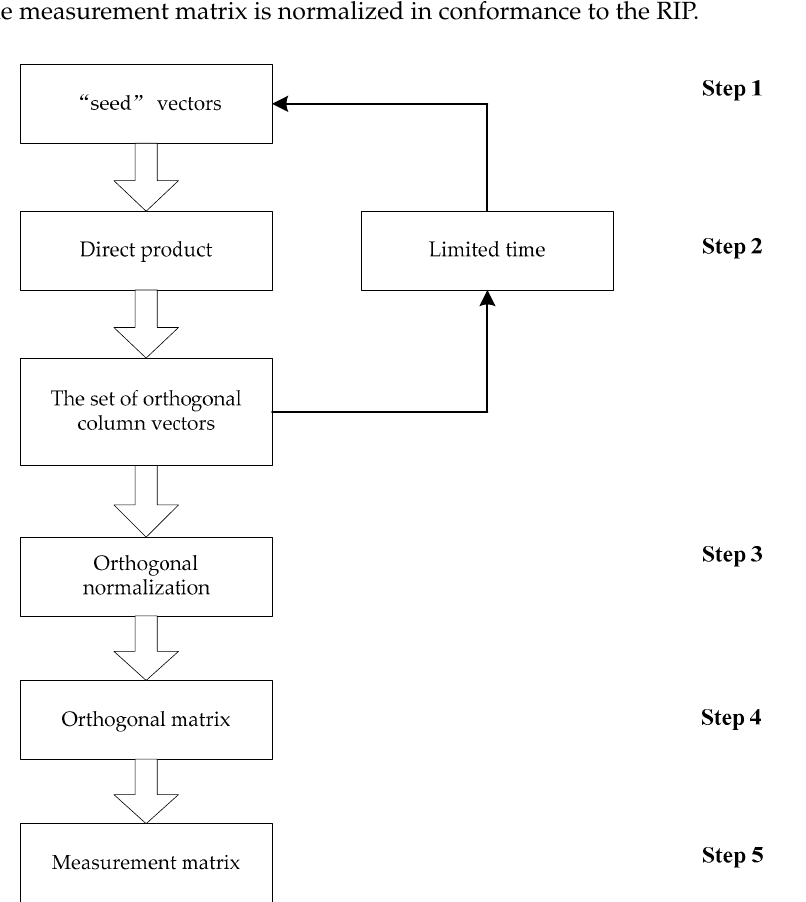
Figure 2. Flowchart for the construction of the measurement matrix by the cyclic direct product and QR decomposition.